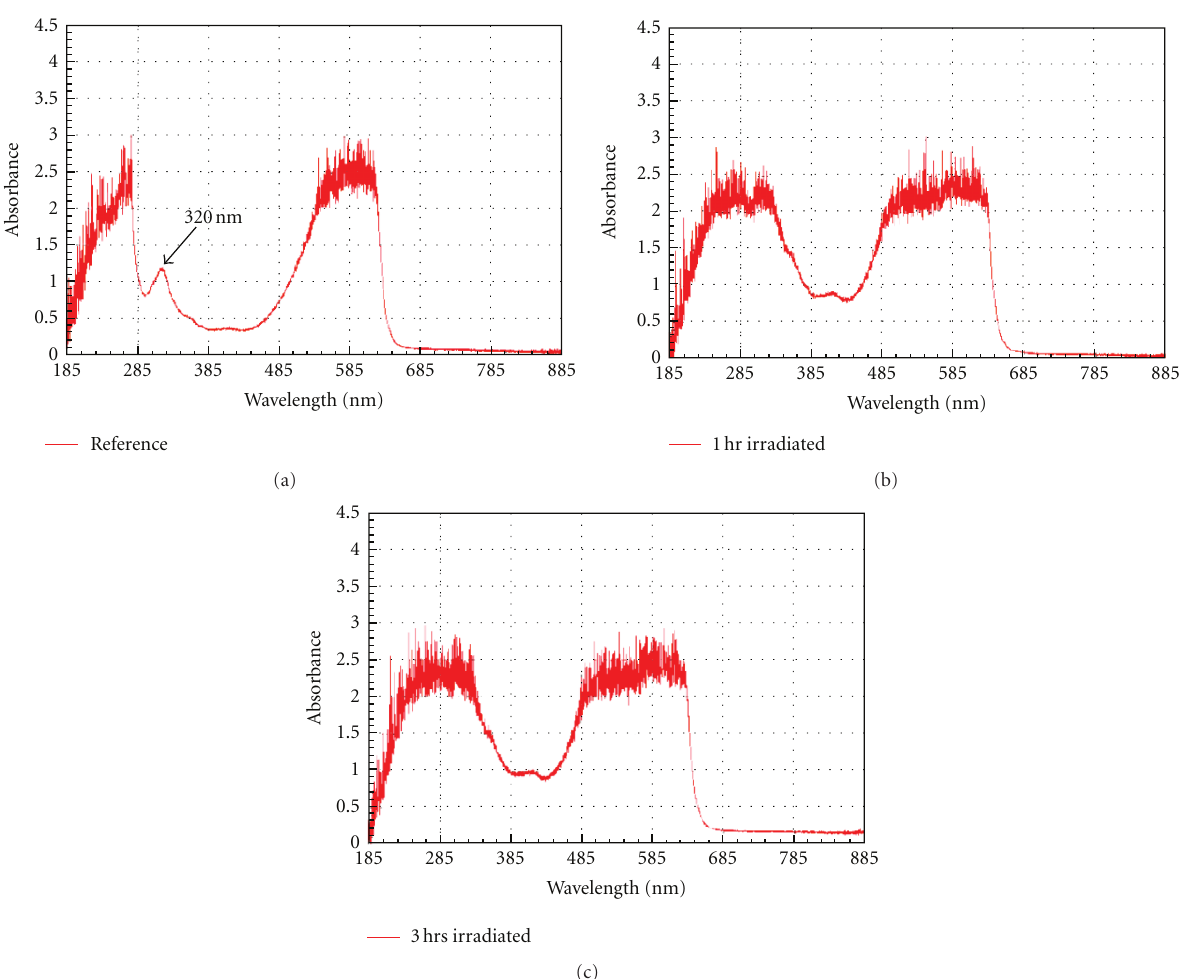
Figure 4: Absorption spectra of cresyl violet in ethanol; (a) reference (non-irradiated), (b) 1 hour irradiated, (c) 3 hours irradiated.